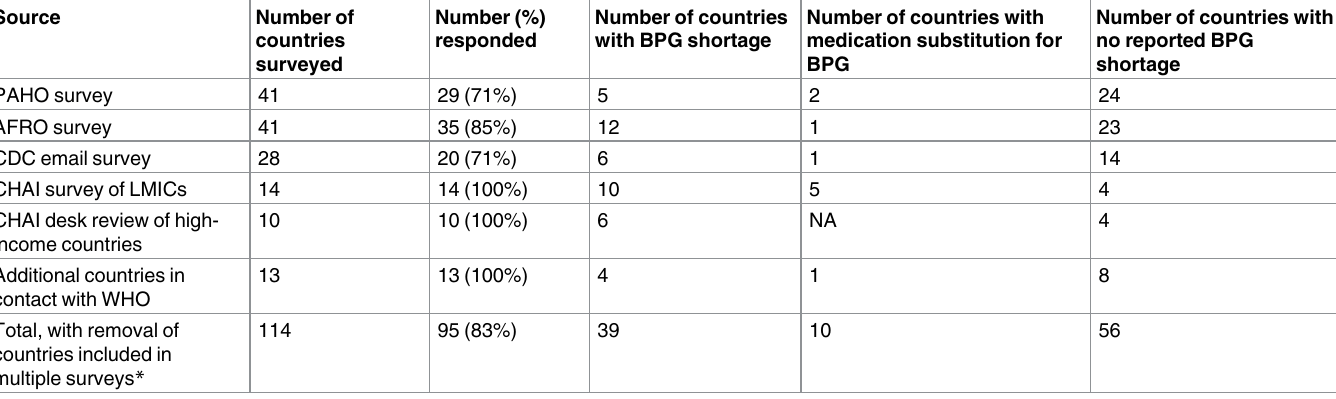
Table 1. Number of countries included in surveysreporting BPG shortage and/or medication substitution for treatment of maternal syphilis.